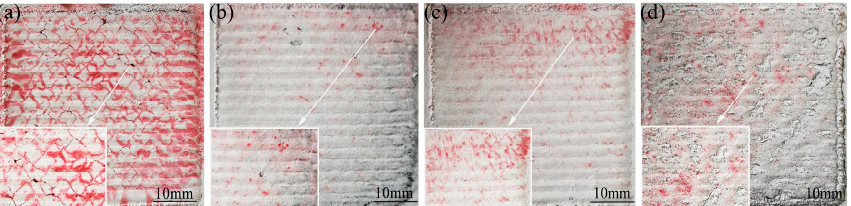
Figure 1. The influence of graphene content on cladding-layer-forming quality: ( a ) 0% graphene mass fraction; ( b ) 0.5% graphene mass fraction; ( c ) 1% graphene mass fraction; ( d ) 1.5% graphene mass fraction.